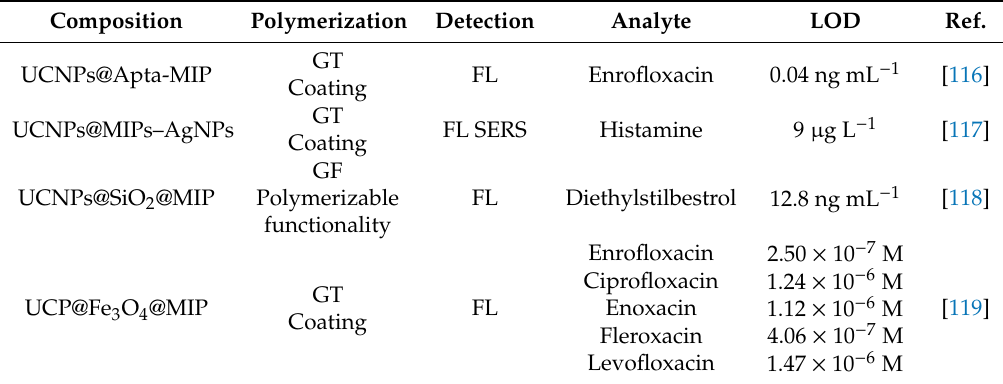
Table 6. Optical sensors based on core-shell MIPs with an up-conversion nanoparticles core.